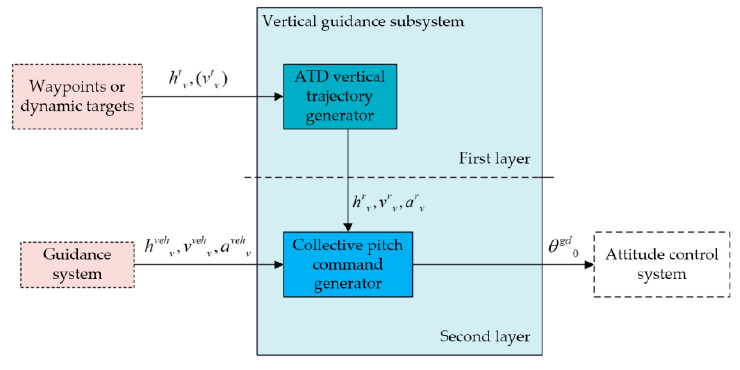
Figure 7. Diagram of altitude guidance subsystem.